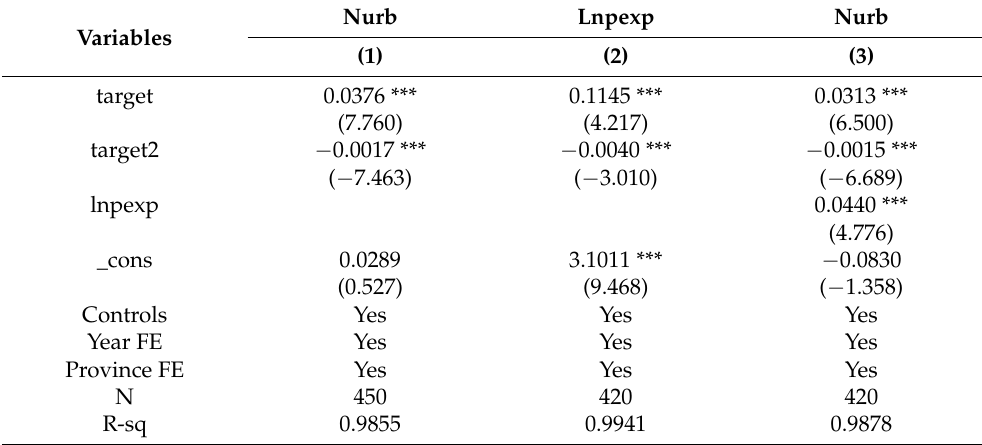
Table 11. Endogeneity